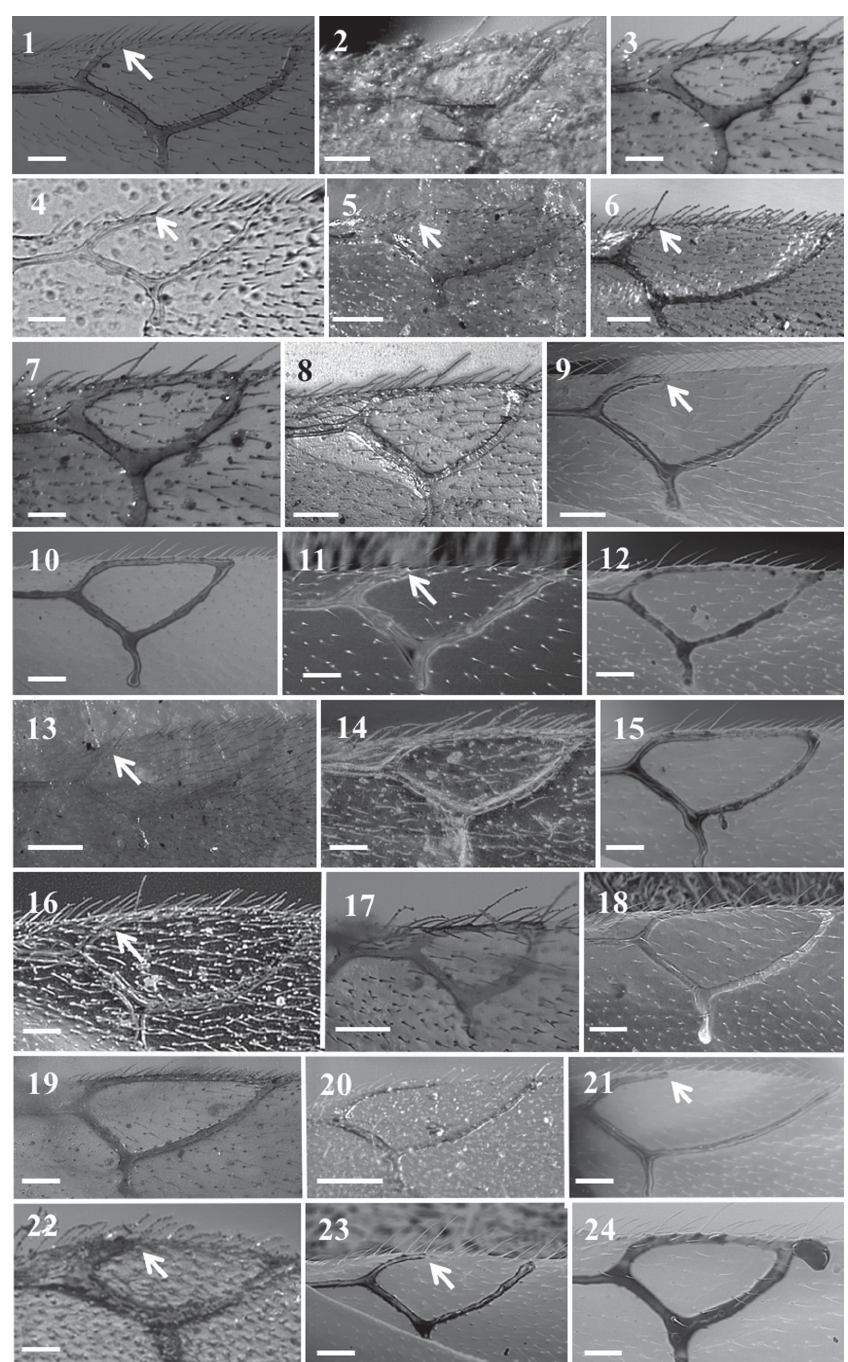
Fig. 4. Types of radial cell of Alloxysta Förster, 1869. 1 . A. abdera Fergusson, 1986. 2 . A. aperta (Hartig, 1841). 3 . A. arcuata (Kieffer, 1902). 4 . A. aurata Belizin, 1968. 5 . A. basimacula